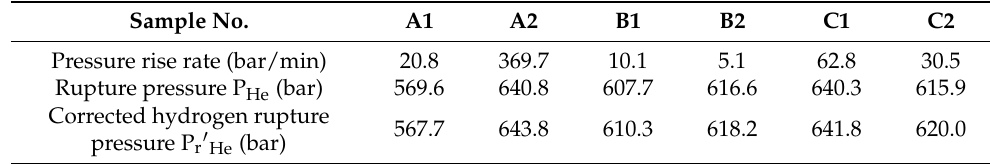
Table 3. Helium rupture pressures of different samples.